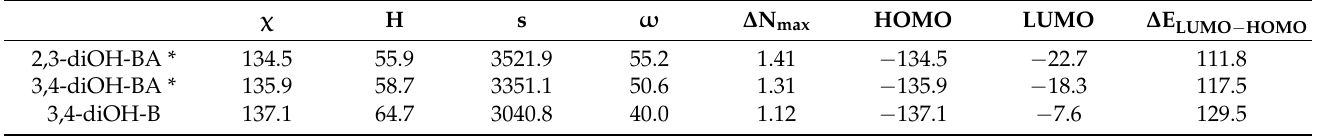
Table 1. Computed reactivity descriptors of tested phenols derived from frontier orbitals in the liquid phase (water) at B3LYP/6-31+G(d,p)//B3LYP/6-311++G(2d,2p) level.